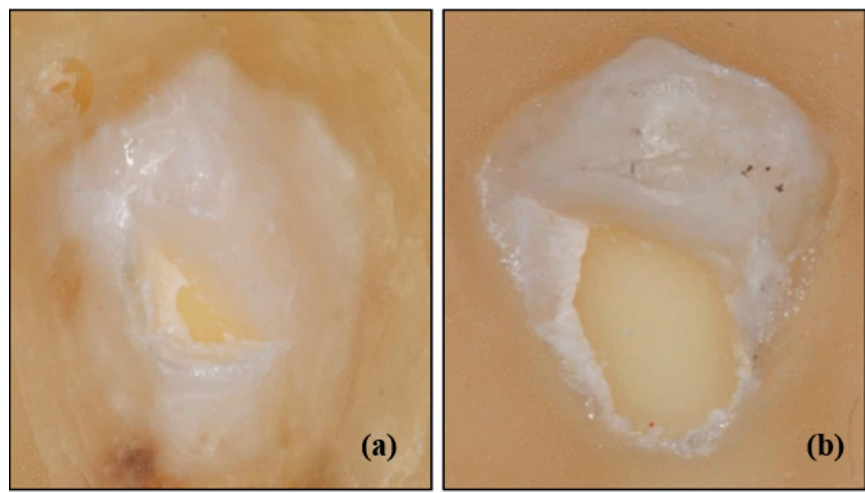
Figure 4. ( a ) Clarity Advanced ceramic brackets with hard tissue (enamel + dentin) damage, ( b ) Clarity Advanced ceramic brackets with severe hard tissue (enamel + dentin) damage.